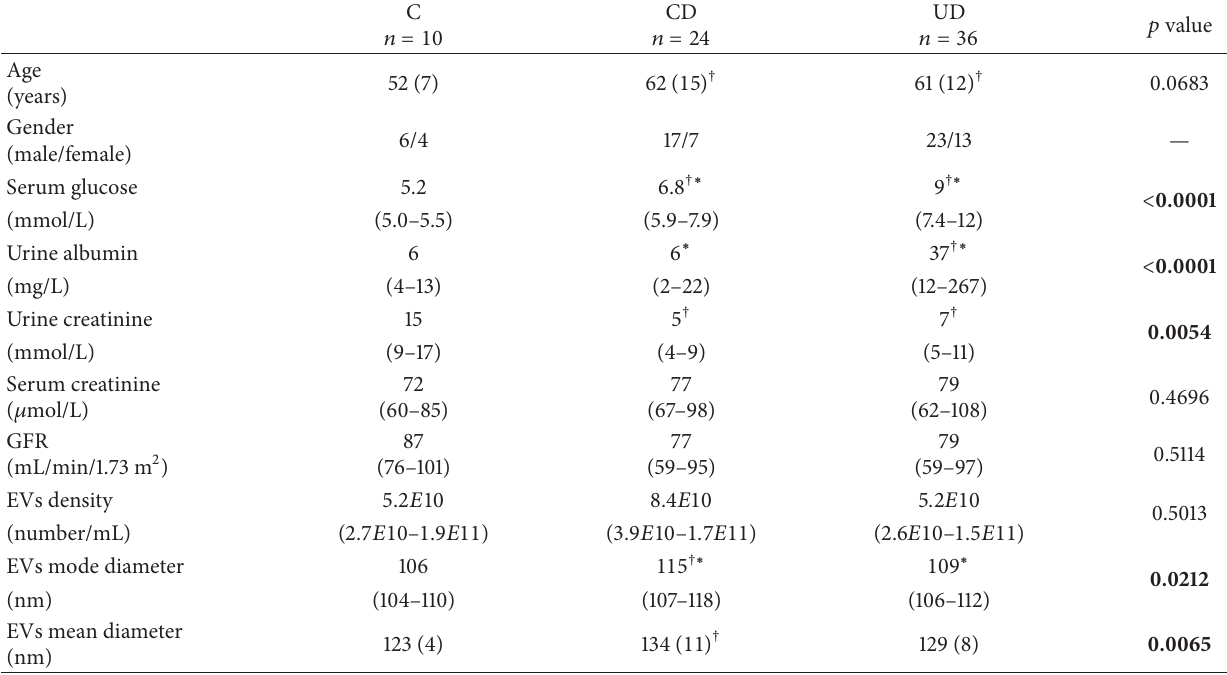
Table 1: Clinical characteristics, blood, and urine biochemistry of study groups: C, CD, and UD.